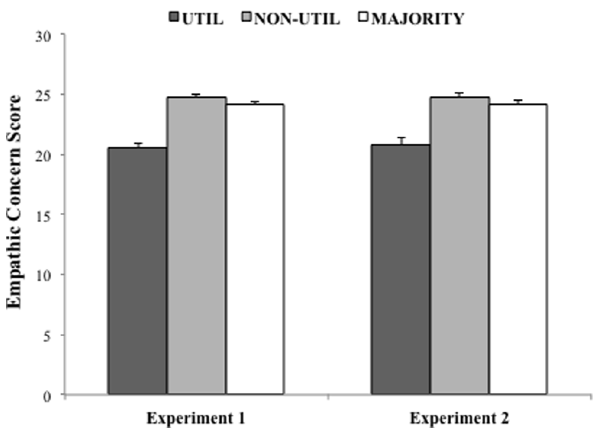
Figure 2. Empathic concern values for participants in the UTIL, NON-UTIL, and MAJORITY groups on the pairs of moral scenarios for Experiments 1 and 2. In both cases, UTIL participants had significantly lower empathic concern scores than participants in the NON-UTIL and MAJORITY groups. Error bars represent S.E.M.